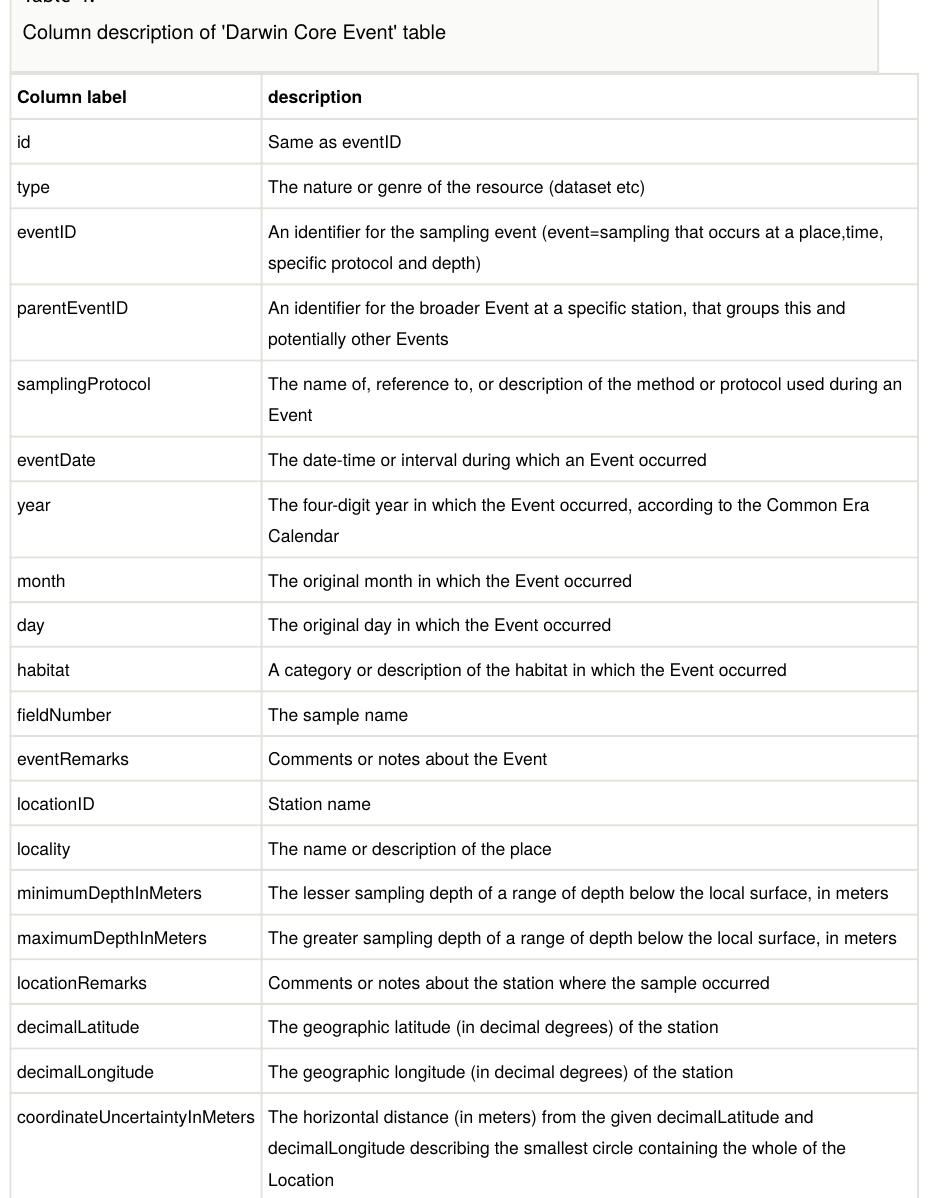
for historical data on the occurrence of benthic macrofaunal species